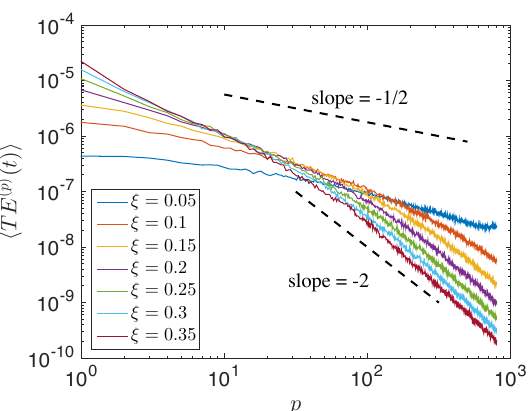
Figure 4. Power law relationship of the weak localization decay curve for different ξ , at later time t ∼ = 875.